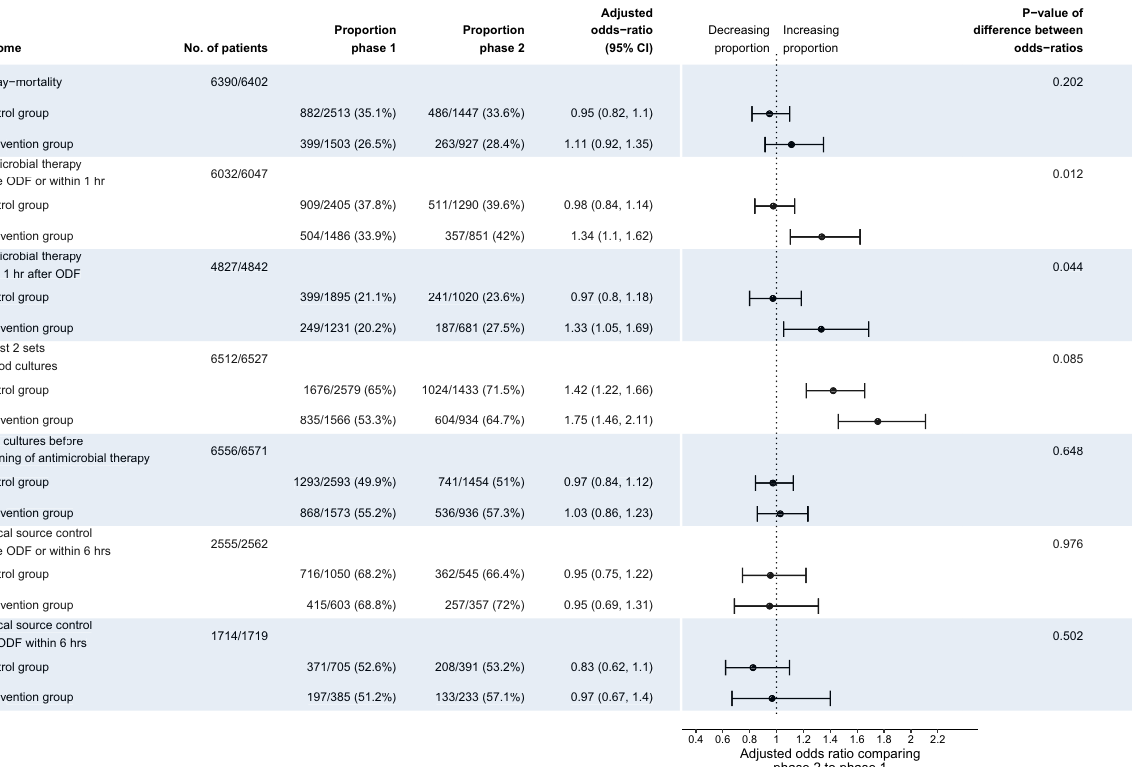
Figure 2. Difference-in-differences analysis of primary and secondary outcomes. Analyses based on data of 40 participating hospitals. Adjusted odds-ratios and p-values result from hierarchical generalized linear models with a logit link adjusted for the covariates age, sex, origin of infection, focus of infection, location at onset of infection and vasopressor use during the first 12 h. Difference-in-differences tested by an interaction effect between study phase and group (control vs. intervention). No. of patients gives the number of cases with complete data both on outcome and confounders compared to the total number of cases were the respective outcome was measured. Intraclass correlations (ICC): 28-day-mortality, ICC = 0.02; Antimicrobial therapy before ODF or within 1 h, ICC = 0.08; Antimicrobial therapy within 1 h after ODF, ICC = 0.04; At least 2 sets of blood cultures, ICC = 0.06; Blood cultures before beginning of antimicrobial therapy, ICC = 0.08; Surgical source control before ODF or within 6 h, ICC = 0.05; Surgical source control after ODF within 6 h, ICC = 0.03.